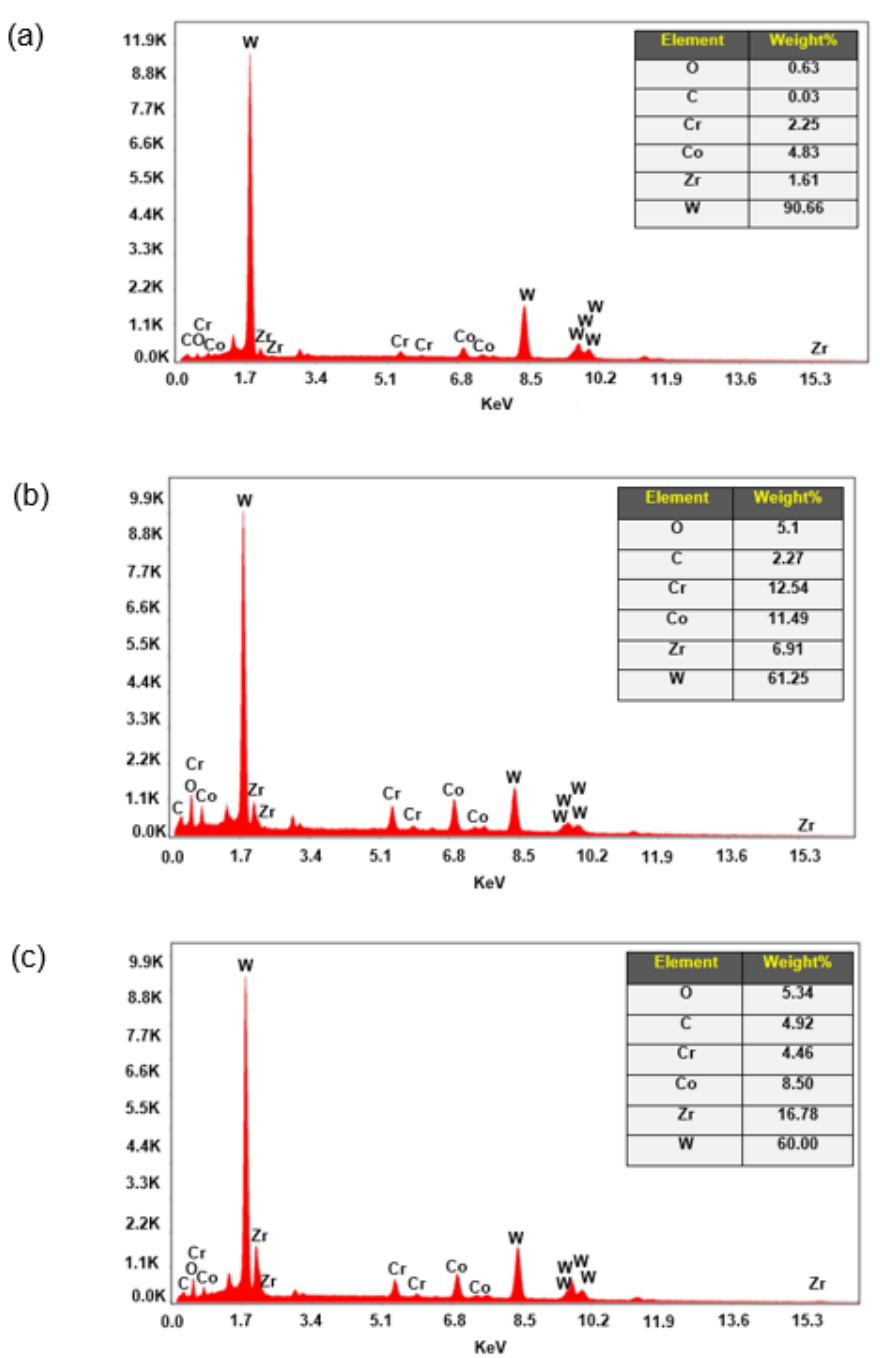
Figure 16. EDS spectra on worn surfaces of the WC-Co-Cr coating under ( a ) 10, ( b ) 20, and ( c ) 30 N applied load.